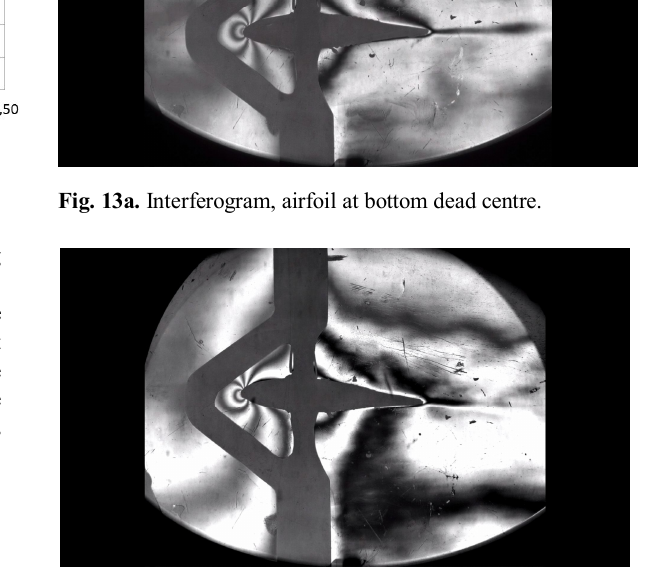
Fig. 13b. Interferogram, airfoil at top dead centre.